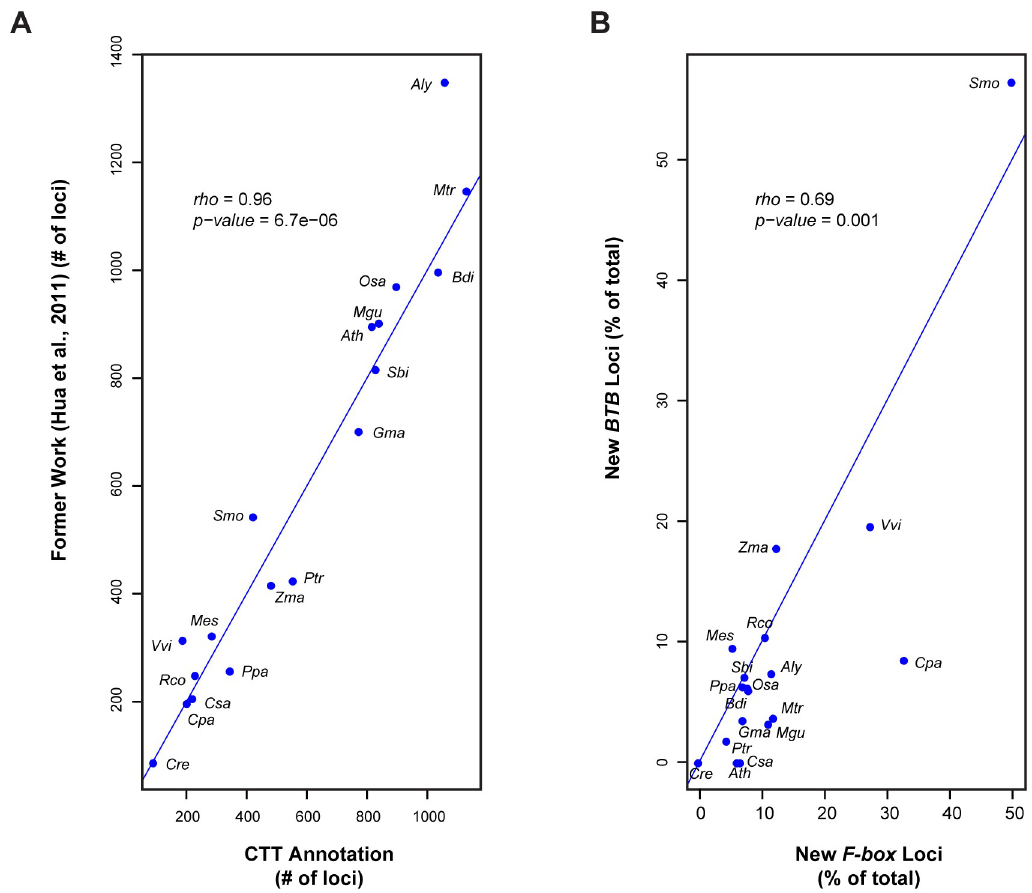
Fig 2. Performance test on the CTT program. ( A) Annotation comparison of the F-box gene superfamily in 18 plant genomes between a previous work [5] and the output of CTT automatic annotation in this work. (B) Number correlation of new F-box and new BTB loci discovered in 18 plant genomes. The blue line indicates equal x axis and y axis values. The full names of the species along with their abbreviations are as listed in S1 Table.